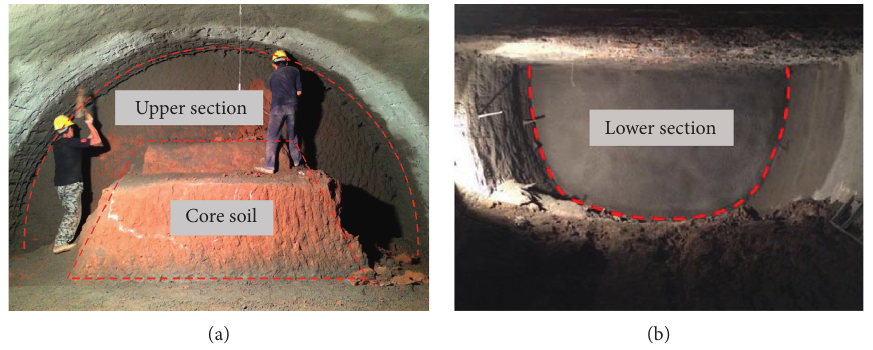
Figure 5: Bench excavation method: (a) upper section, (b) lower